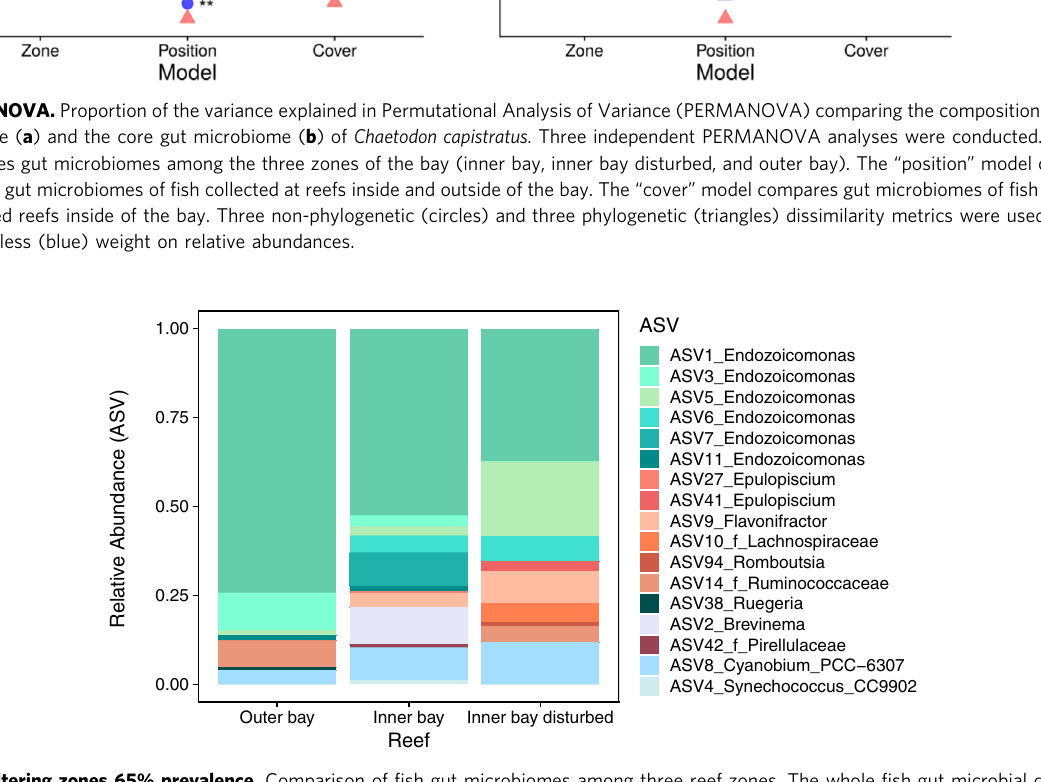
Fig. 6 PIME fi ltering zones 65% prevalence. Comparison of fi sh gut microbiomes among three reef zones. The whole fi sh gut microbial dataset was fi ltered using Prevalence Interval for Microbiome Evaluation (PIME) 134 to detect which ASVs were responsible for differences among zones. Using machine learning, PIME de-noises the data by reducing within-group variability. Based on the algorithm, we selected a 65% prevalence cut-off resulting in a fi ltered dataset of 17 ASVs at a low error rate (OOB = 2.25) and high model accuracy